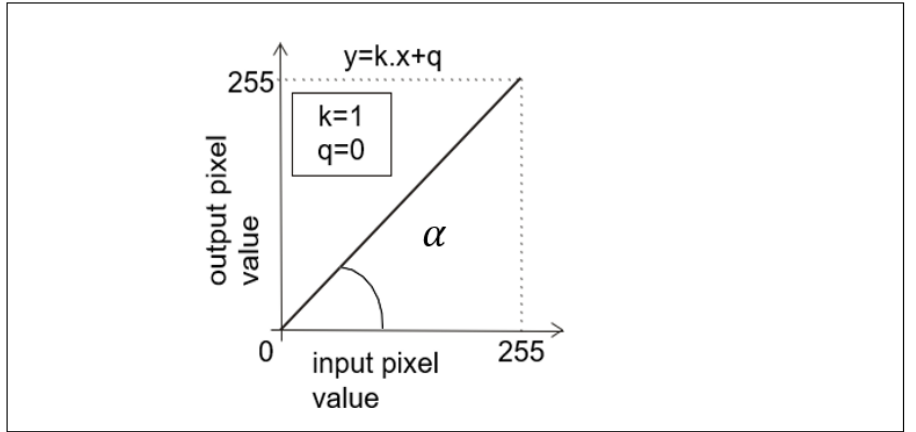
Figure 3. Example of a point operator (function) that implements a copy of the input image on the output. In this case, the value of the slope (i.e., k = 1), and the value of the y-intercept of a straight line where a line crosses y -axis of a graph (i.e., q = 0).